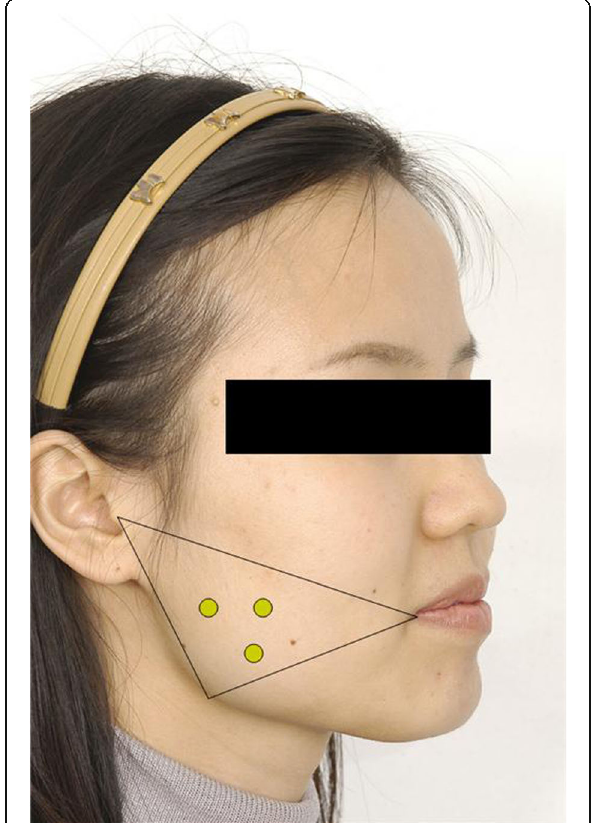
Fig. 4 Picture demonstrating the three injection points. Injection point is within the triangle made by a line connecting the mouth corner, the tragus, and the angle of the mandible. Inject deep into the muscle, careful not to touch the